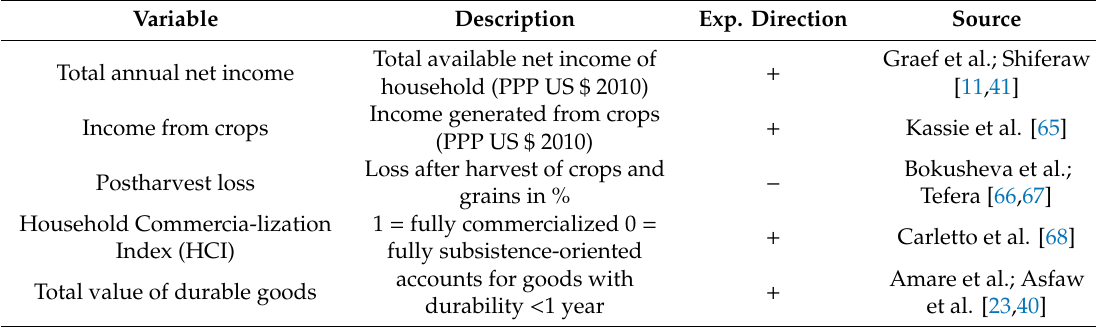
Table 1. Well-being